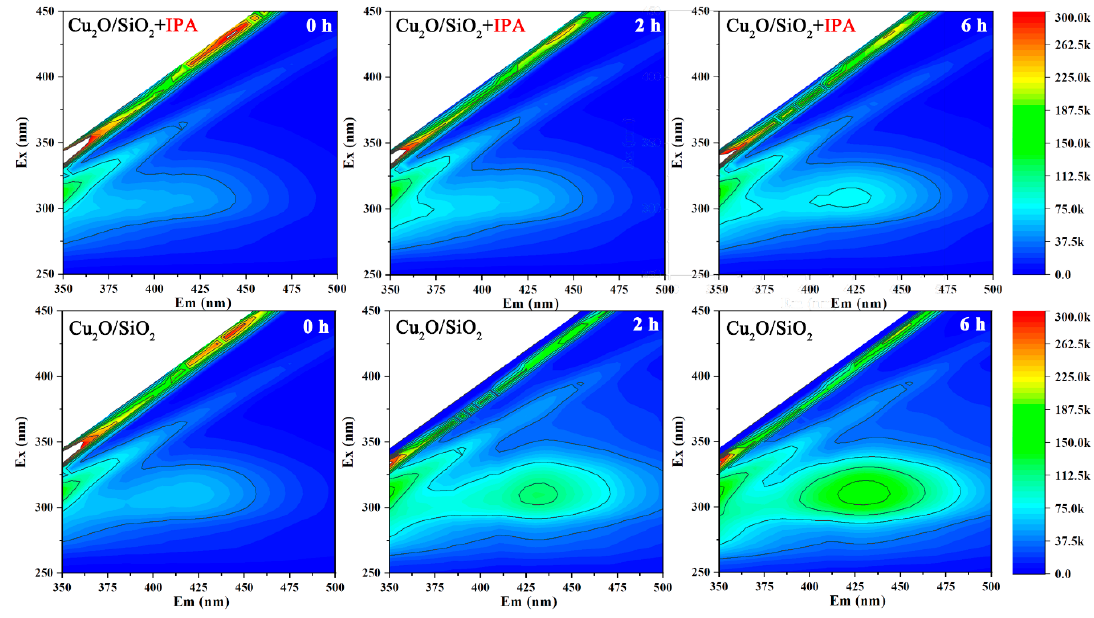
· OH concentration change with